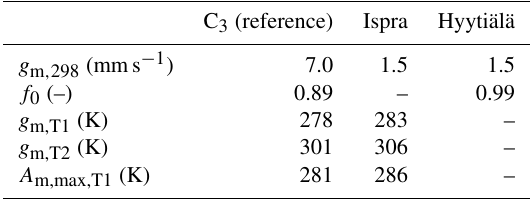
Table A1. A - g s parameter settings used in MLC-CHEM simula- tions. The first column indicates the default C 3 settings from Ronda et al. (2001), and the other two columns show the optimal set- tings from our analysis. A dash (–) indicates that a parameter is unchanged with respect to the default C 3